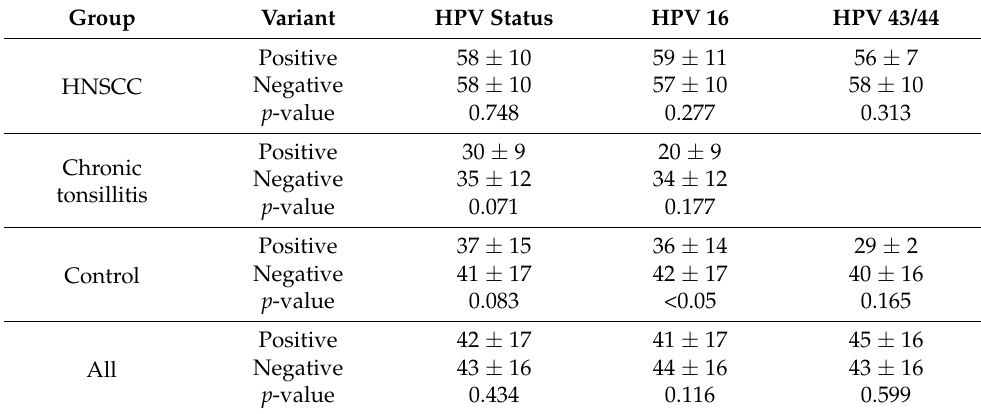
Table 5. Summary of mean values and standard deviation for age (years) in individual groups, considering the type of HPV and the results (negative, positive).